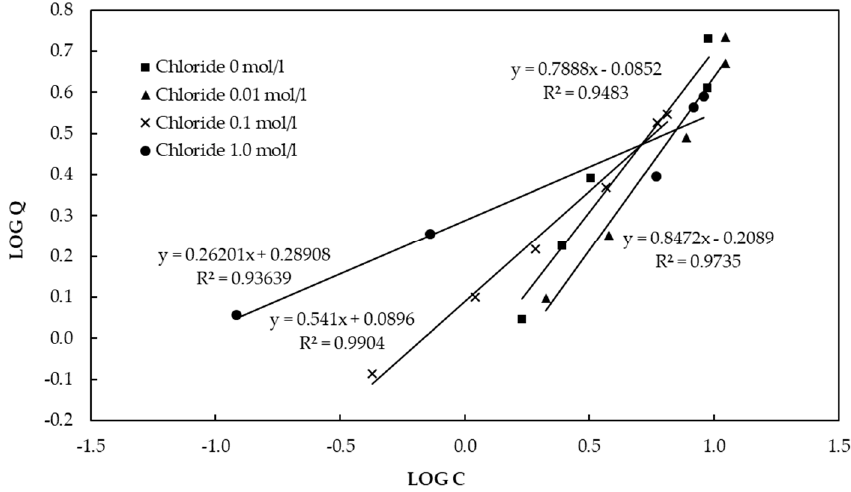
Figure 9. Freundlich isotherm for CBC in the presence of chloride.